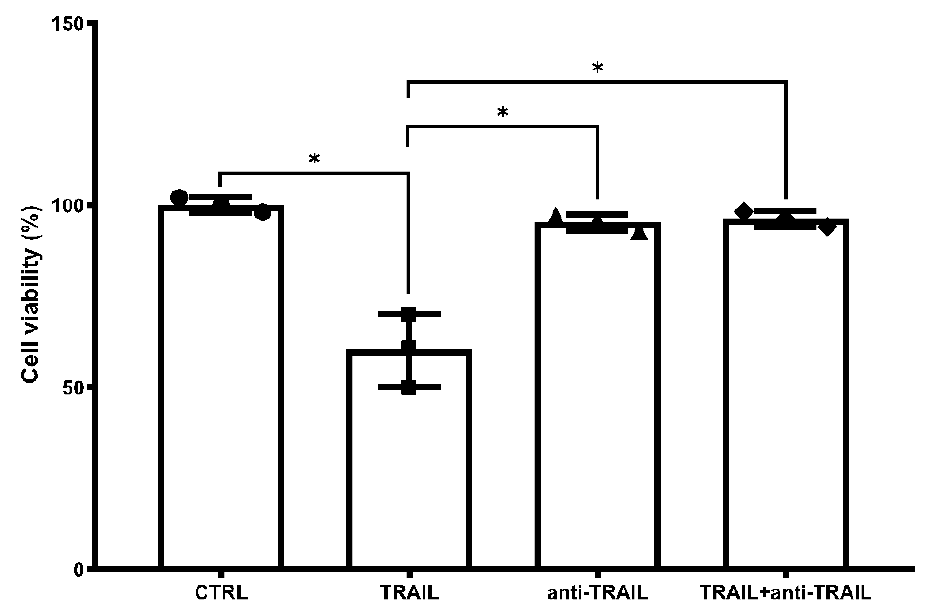
Figure 2. Cell viability percentage after 72 h of treatment with TRAIL (100 ng/mL), anti-TRAIL (1 µg/mL) or the combination of the compounds. Data are expressed as mean ± SD. One-way ANOVA followed by the Fisher’s LSD test were used for statistical analysis. * p < 0.05.